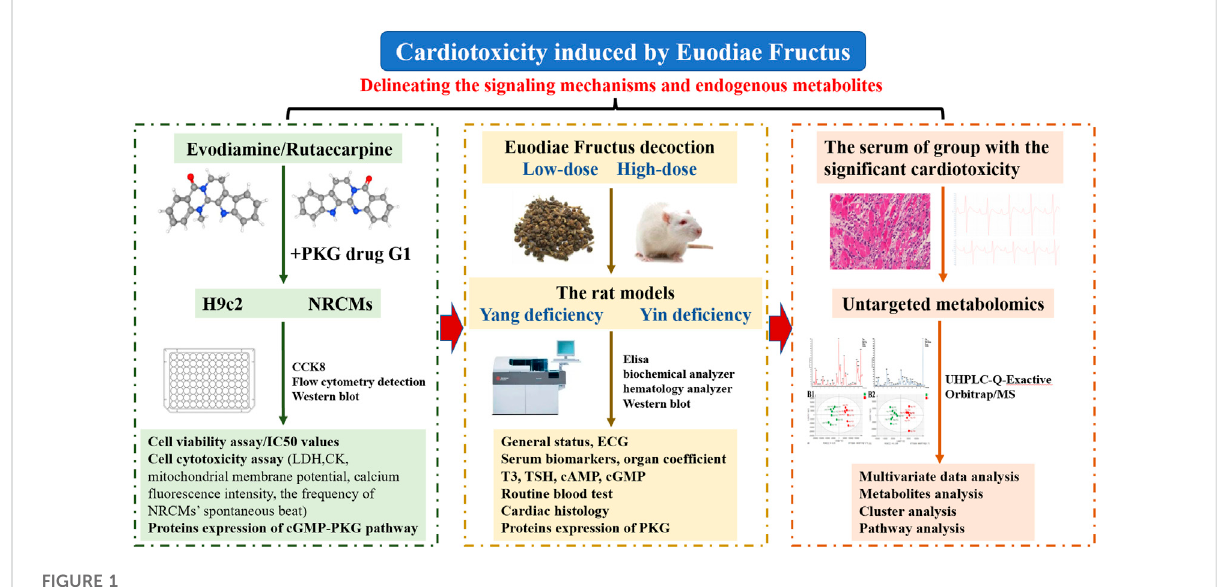
FIGURE 1 The fl owchart of the technical strategy in the present